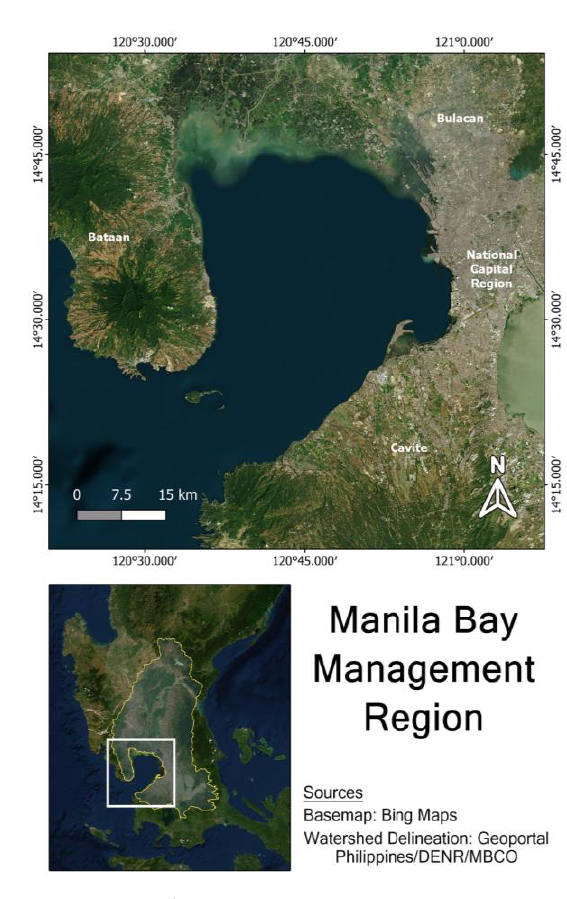
Figure 1 . Manila Bay